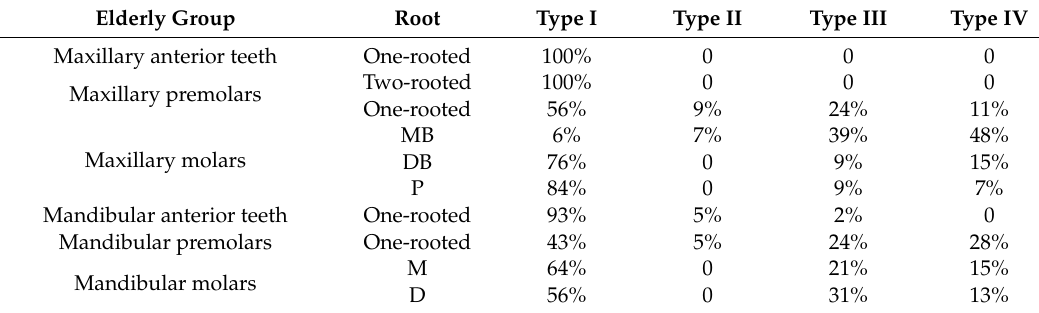
Table 5. Changes of cross-sectional root canal shape in elderly age